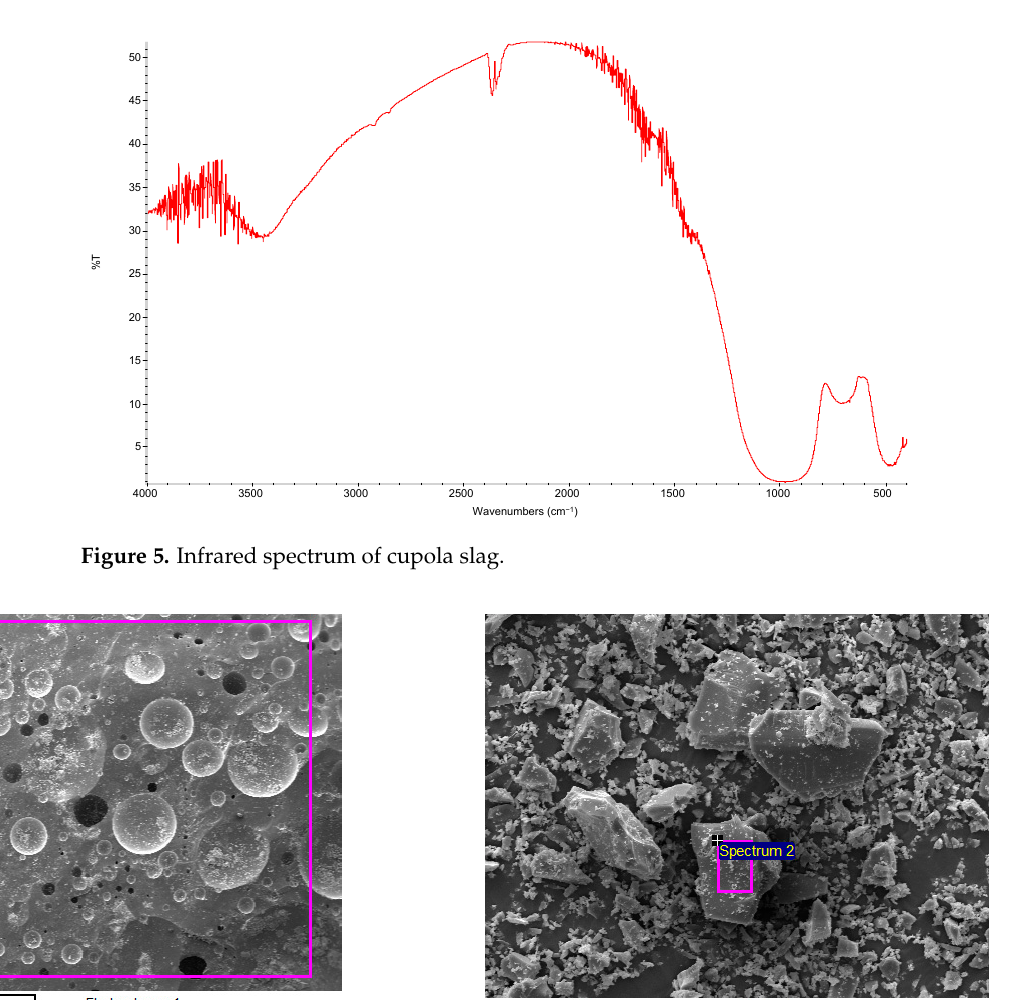
Figure 6. Micrograph of a cupola slag particle at two different scales: low ( a ) and high level of magnification ( b ).